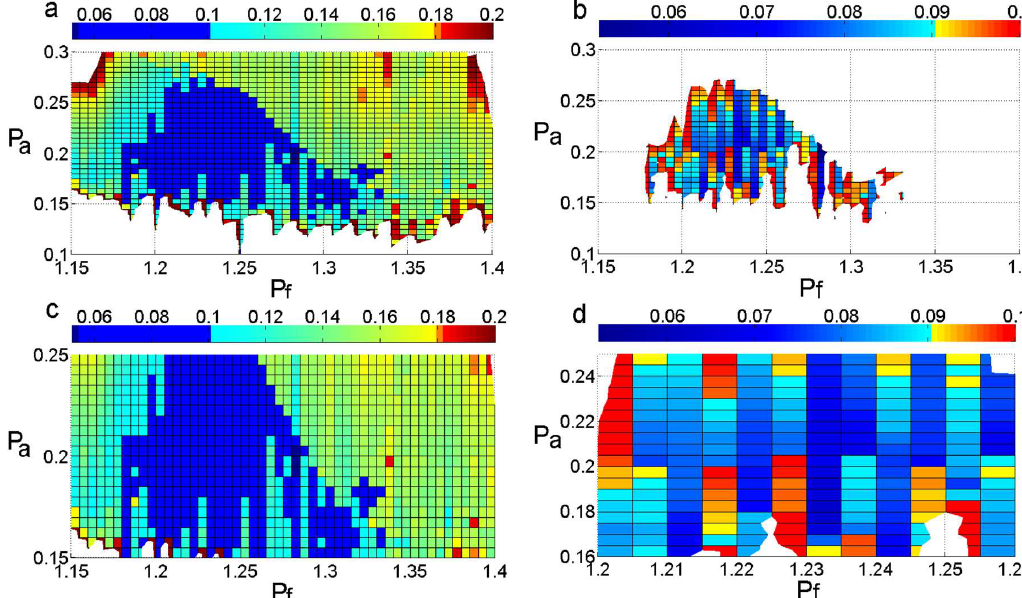
Figure 12. The distribution of the NMSE. ( a ), ( c ) show the NMSE values that are less than 0.2; ( b ), ( d ) show the NMSE values that are less than 0.1. the NMSE values that are less than